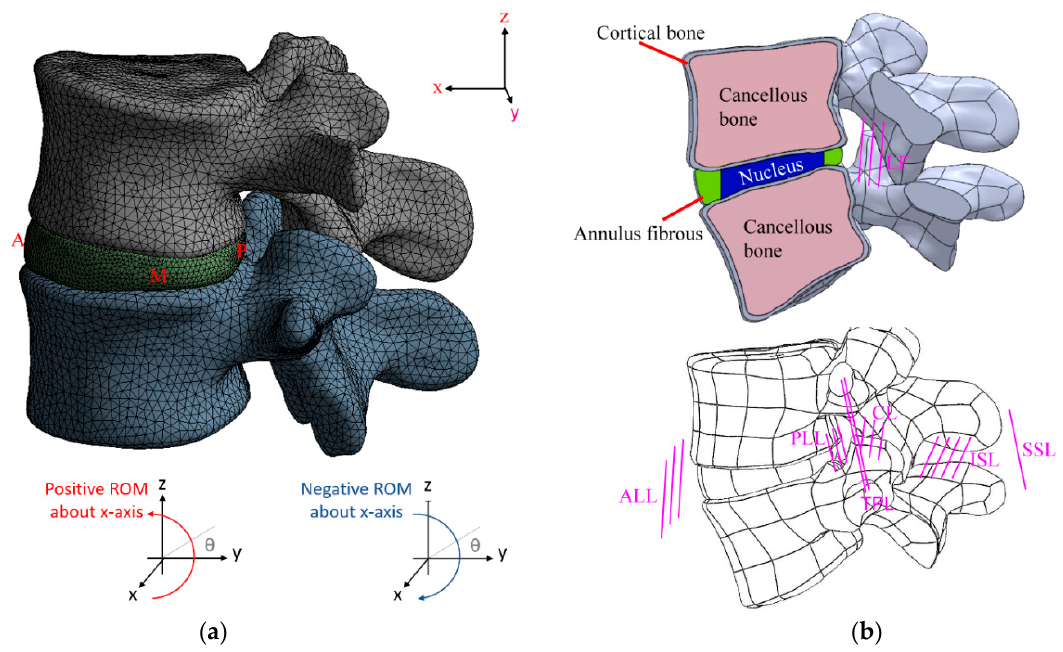
Figure 1. L3–L4 spine segment model: ( a ) finite element mesh; ( b ) model containing supraspinous ligament (SSL), interspinous ligament (ISL), capsular ligaments (CL), transverse process ligaments (TPL), posterior longitudinal ligament (PLL), anterior longitudinal ligament (ALL), and ligamentum flavum (LF). Table 1. Material properties of lumbar spine model.